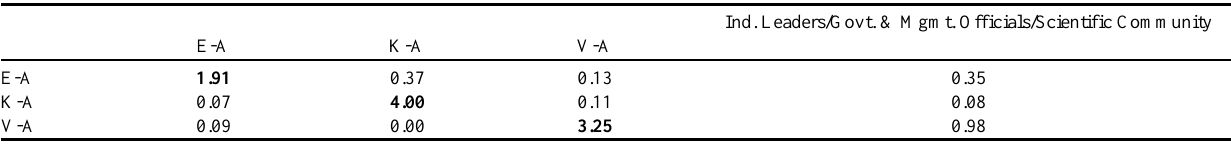
Table 3 . Relational contingency table (RCT) analysis results by ethnicity on all identified Hawaii’s longline fishery (HLF) ties. Values are reported as the proportion of observed vs. expected number of ties within and between groups, where a value of 1.00 represents the expected number of ties. Values in bold indicate a higher proportion of ties than would be expected in a network of the same size and number of ties under a model of